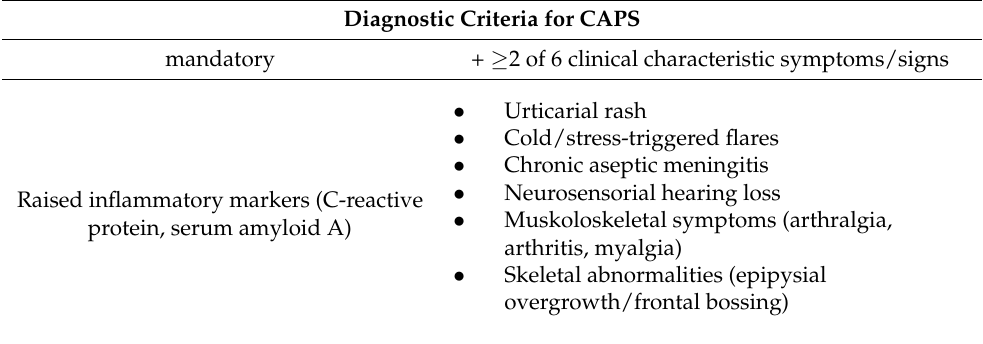
Table 2. Diagnostic criteria for CAPS (data from